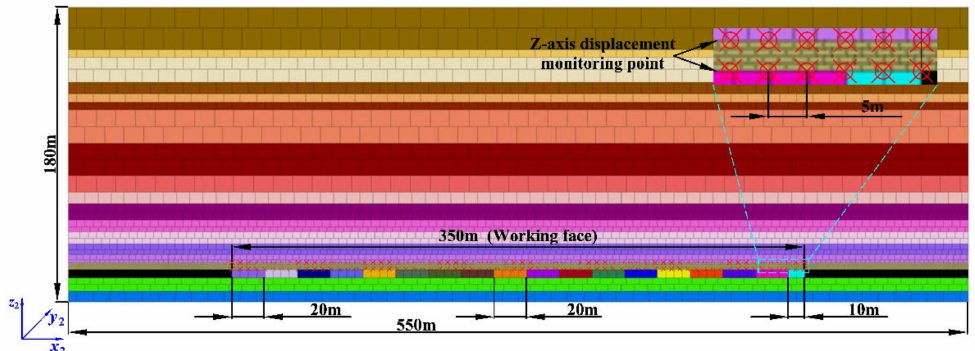
Figure 4. Strike model of the adjacent working face.